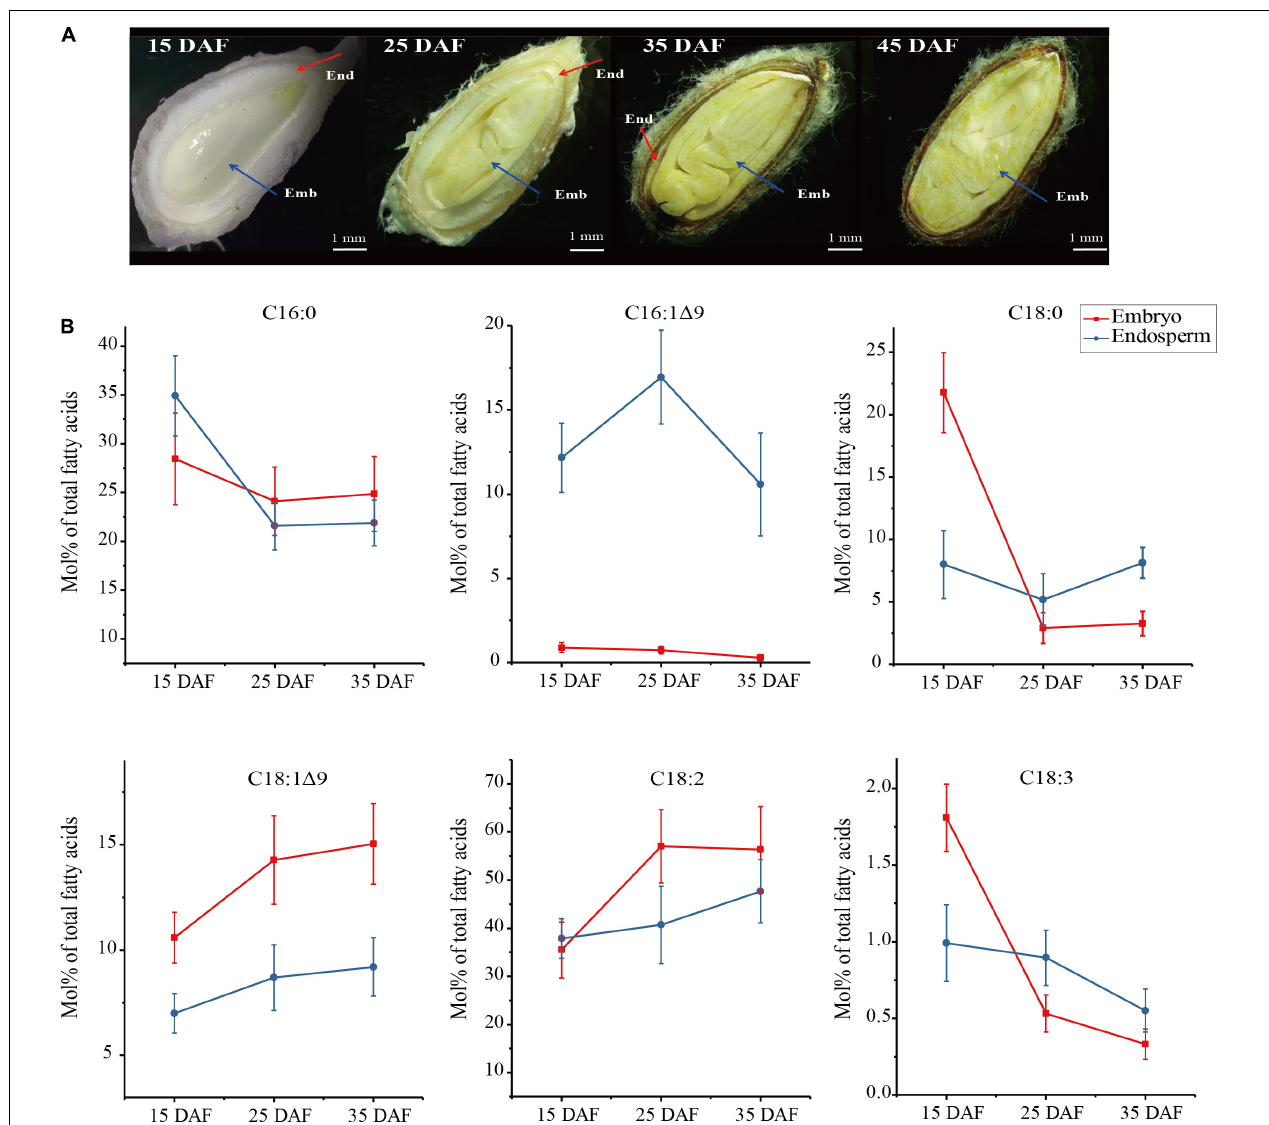
FIGURE 1 | Four development stages of cotton seeds (A) and fatty acid profiles in developing embryo and endosperm (B) . Fatty acid content (Mol%) was presented as a percentage of all fatty acids in embryo and endosperm, respectively. Values are the mean ± SE of six biological